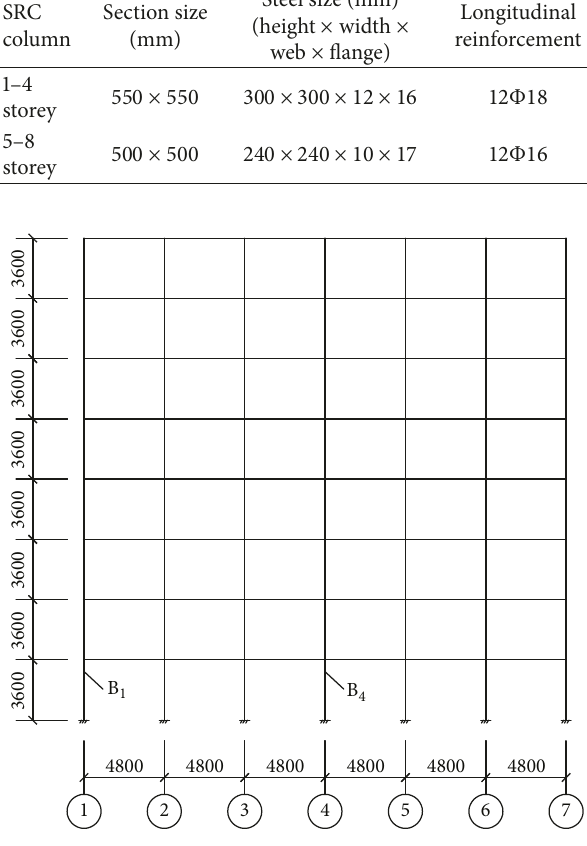
Figure 8: Elevation drawing of the hybrid frame